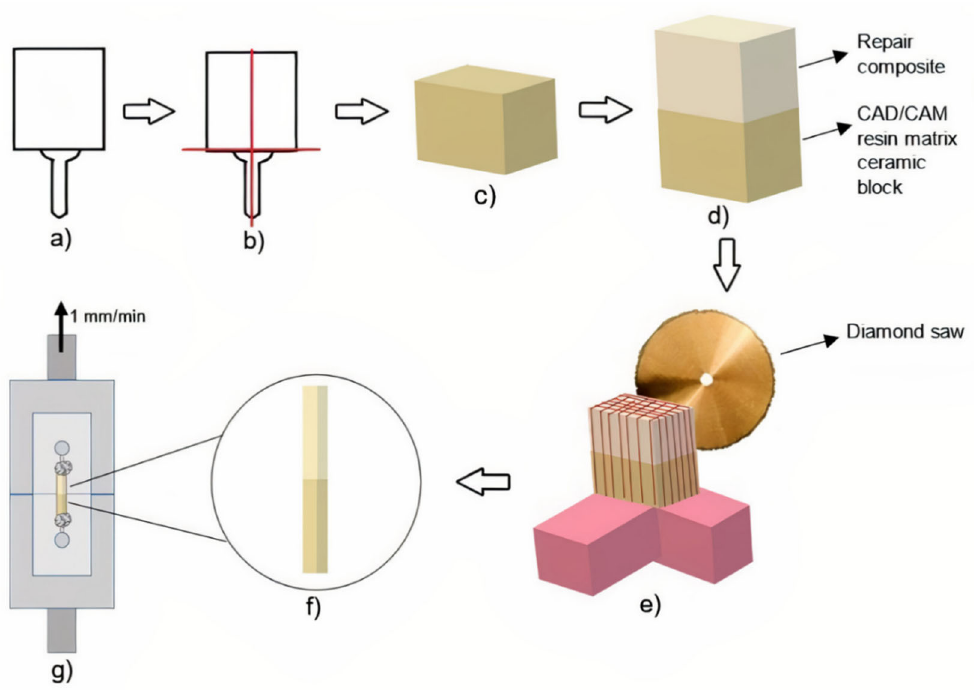
Figure 2. Preparation steps of RMC blocks for micro-tensile bond strength test: ( a ) RMC block; ( b ) Blocks sectioned into two parts by cutting horizontally and vertically with precision cutting machine; ( c ) Resulting block with dimensions of 14 × 16 × 6 mm 3 ; ( d ) Application of 6 mm repair composite onto RMC block; ( e ) Horizontal and vertical cuts made with 1 mm intervals with precision cutting machine; ( f ) Non-trimmed bar specimens reduced to 1 × 1 × 12 mm 3 dimension; ( g ) Micro-tensile test performed by sticking the specimens to the Geraldeli’s Jig from both ends with cyanoacrylate